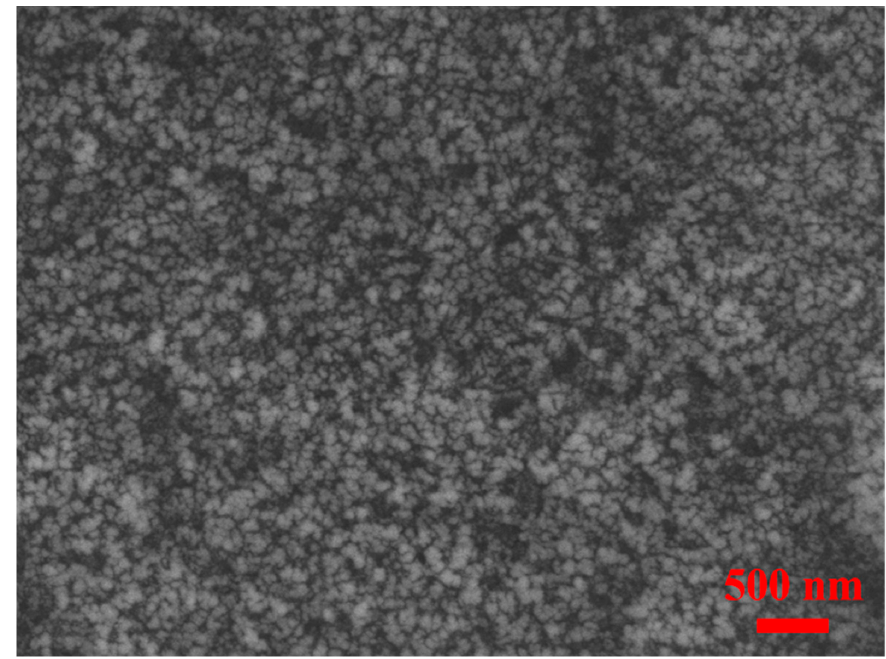
Figure 5. Image of the micro-convex composed of hydrophobic nanoscale SiO 2 NPs. Theoretically, ∆ P (Pa) of the fibrous membrane is described by the Young–Laplace equation[6]: